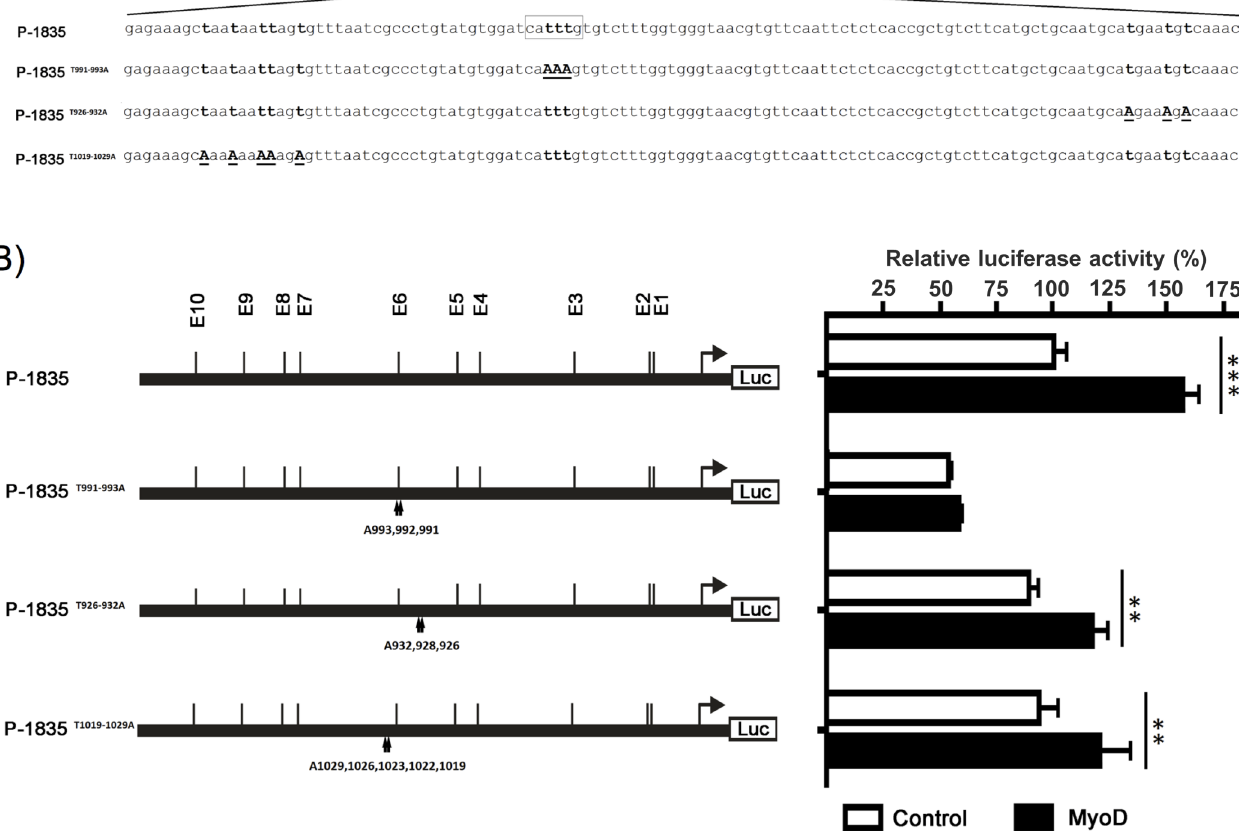
PLOS ONE | https://doi.org/10.1371/journal.pone.0186506 October 16,